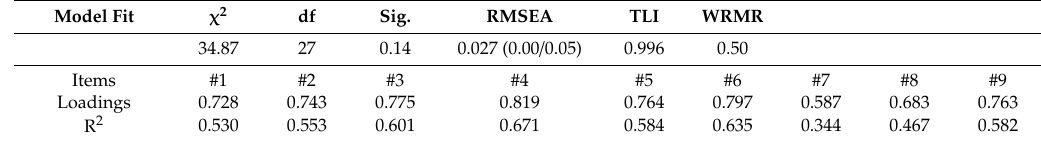
Table 3. Model fit of the SCL-K-9.